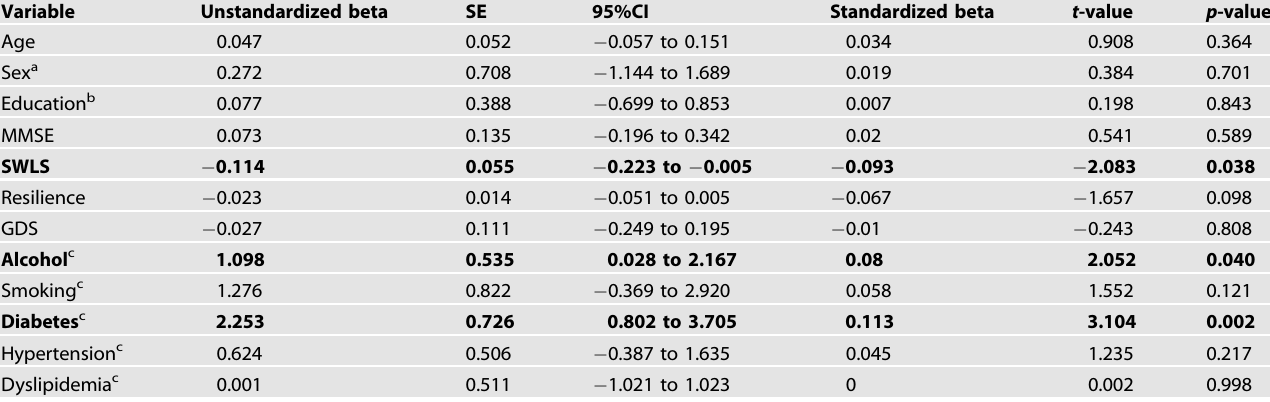
Table 2. Results of multiple regression analysis with the Brain-PAD score as a dependent variable.